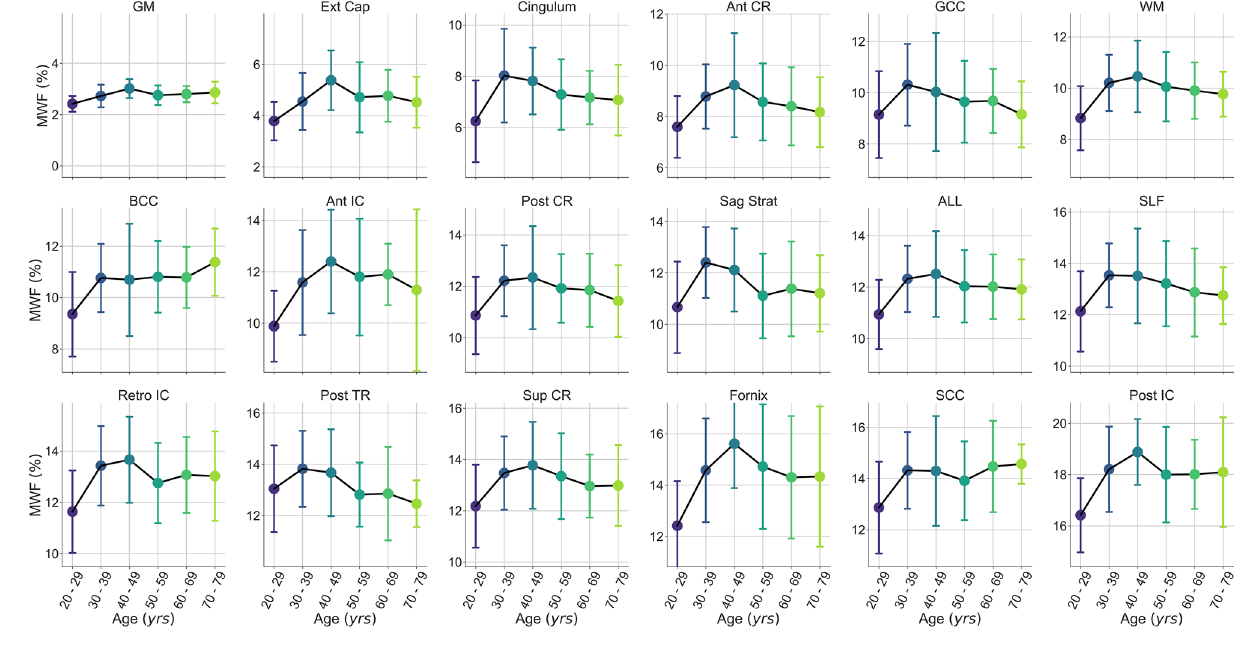
Figure 5. Mean myelin water fraction (MWF) values versus subject age (grouped by decade) within gray/white matter (GM/WM), external capsules (Ext Cap), cingulum, anterior/posterior/superior corona radiata (Ant/Post/ Sup CR), anterior/posterior/retrolenticular internal capsule (Ant/Post/Retro IC), sagittal stratum (Sag Strat), all JHU labels (ALL), superior longitudinal fasciculus (SLF), posterior thalamic radiation (Post TR), fornix (Fornix), and genu/body/splenium of corpus callosum (G/B/S CC). Uncertainty bars were calculated as the standard deviation of values across subjects within each age group.